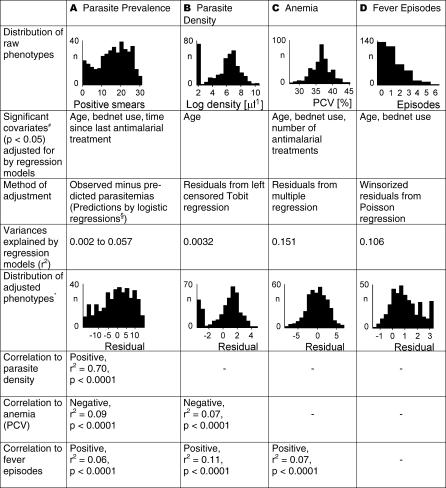
Phenotype Adjustments of the Study Group (392 Siblings)(A) Presence of asexual blood forms of P. falciparum in 31 weekly blood smears.(B) Log of the 75th percentile of 31 parasite density values per individual.(C) Median of 16 PCV assessments per individual.(D) Malaria fever episodes were defined following WHO recommendations whereby multiple malaria attacks within 3 wk were considered recrudescences and counted as one episode (see Materials and Methods).
#Gender did not significantly influence any of the phenotypes. For the phenotype of parasite density, the effects of antimalarial treatments were addressed by exclusion of density values following 3 wk after treatment (see Materials and Methods). The phenotype of fever episodes was not corrected for the number of antimalarial treatments because of the direct causal relationship between disease episodes and treatments.
§31 weekly regression models.
*Anemia (PCV) was normally distributed, Shapiro-Wilk W test, p > 0.2.